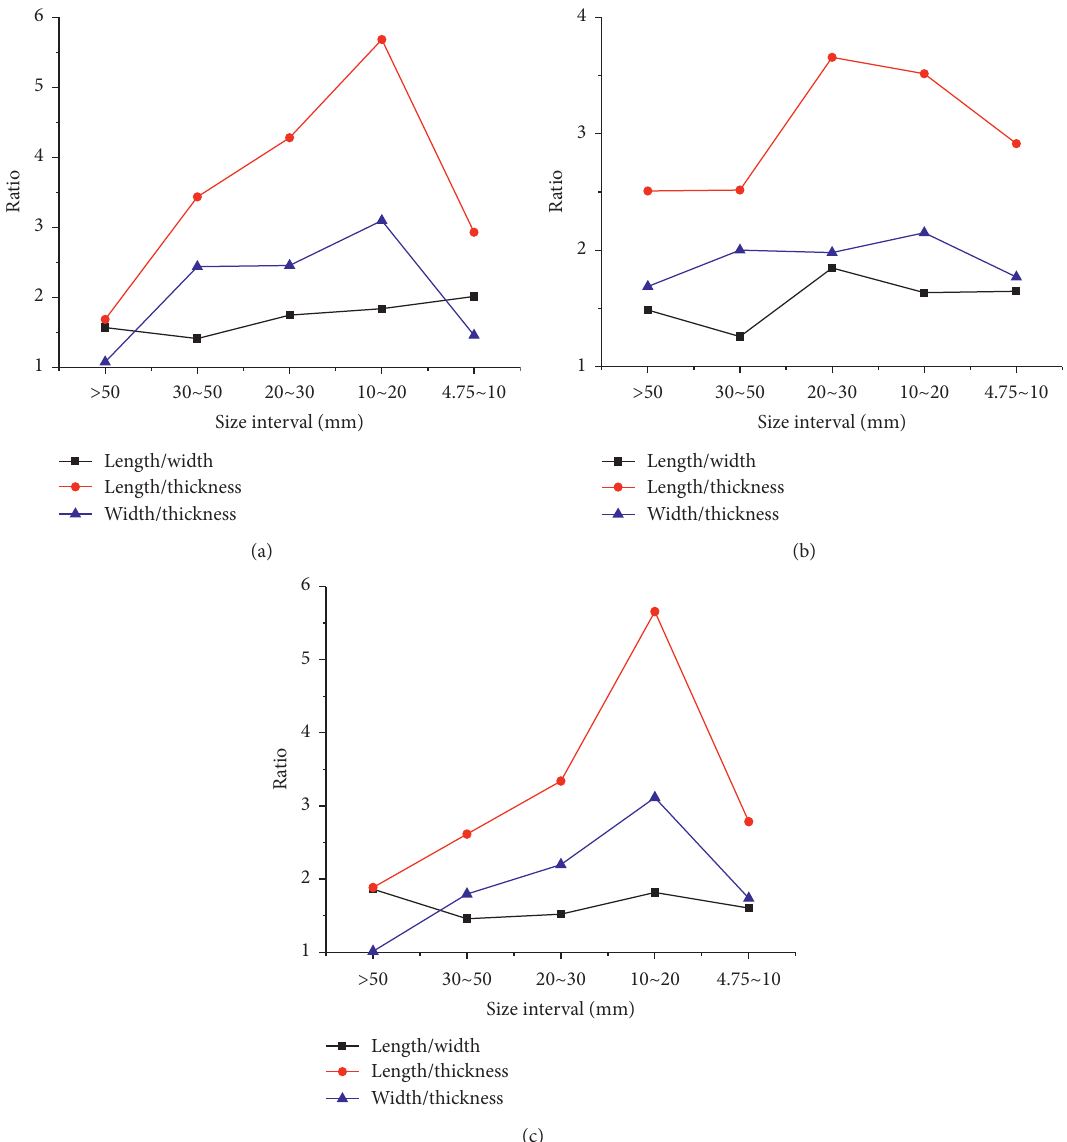
Figure 14: Size characteristics of limestone specimen fragments obtained under the confining pressure of 10MPa. (a) Conventional compression test. (b) Cyclic loading test with a frequency of 0.25Hz. (c) Cyclic loading test with a frequency of